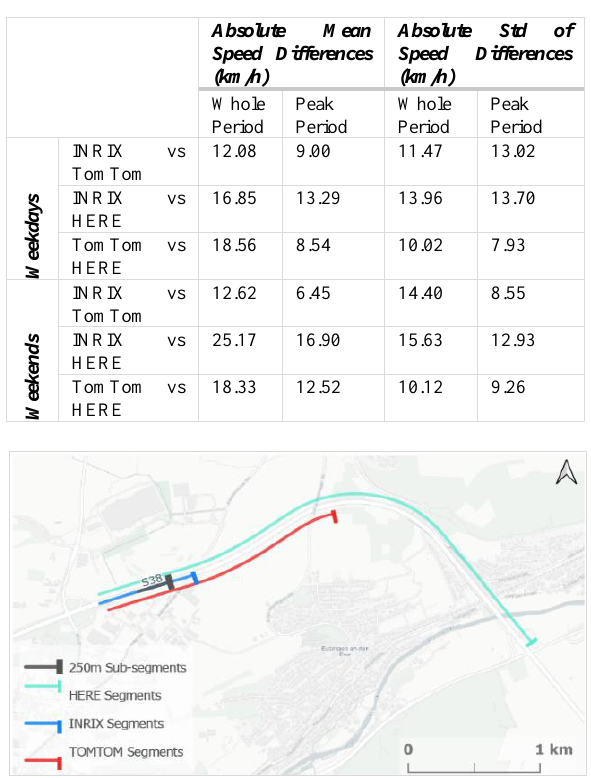
Table 1: Absolute mean and standard deviations of FCD speeds over different periods for sub-segment S38